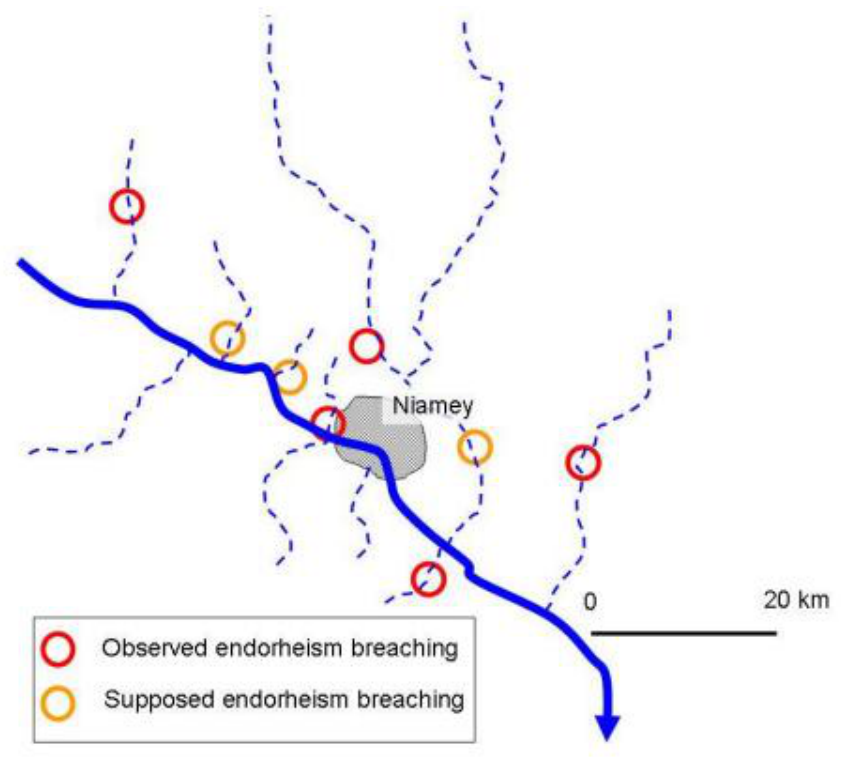
Figure 16. Location of recent endorheism ruptures observed near Niamey, in the middle reach of the Niger